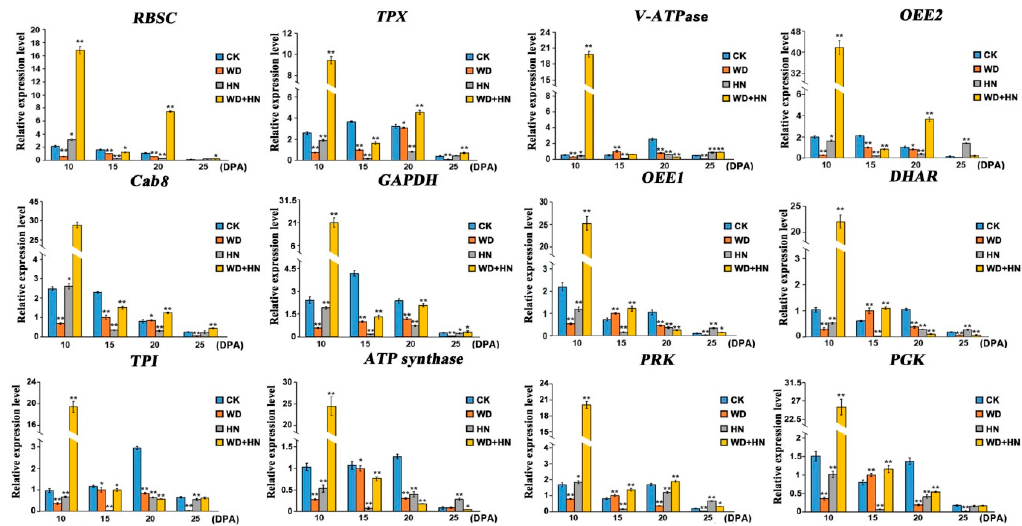
Figure 7. Transcription expression patterns of the genes of 12 representative di ff erentially accumulated proteins from wheat flag leaves during grain development by quantitative real-time PCR analysis. CK: regular watering and N fertilization; WD: no watering and regular N fertilization; HN: regular watering and high-N fertilization; WD + HN: no watering and high-N fertilization; DPA, days post-anthesis. For gene abbreviations, see the main text. Significant di ff erences compared to the control were calculated based on independent Student’s t -test: * p < 0.05; ** p <